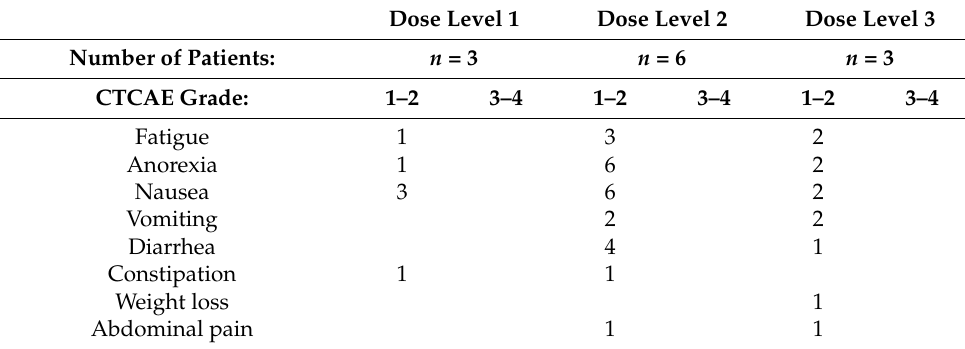
Table 4. Possible, probable or definitive treatment-related adverse event.